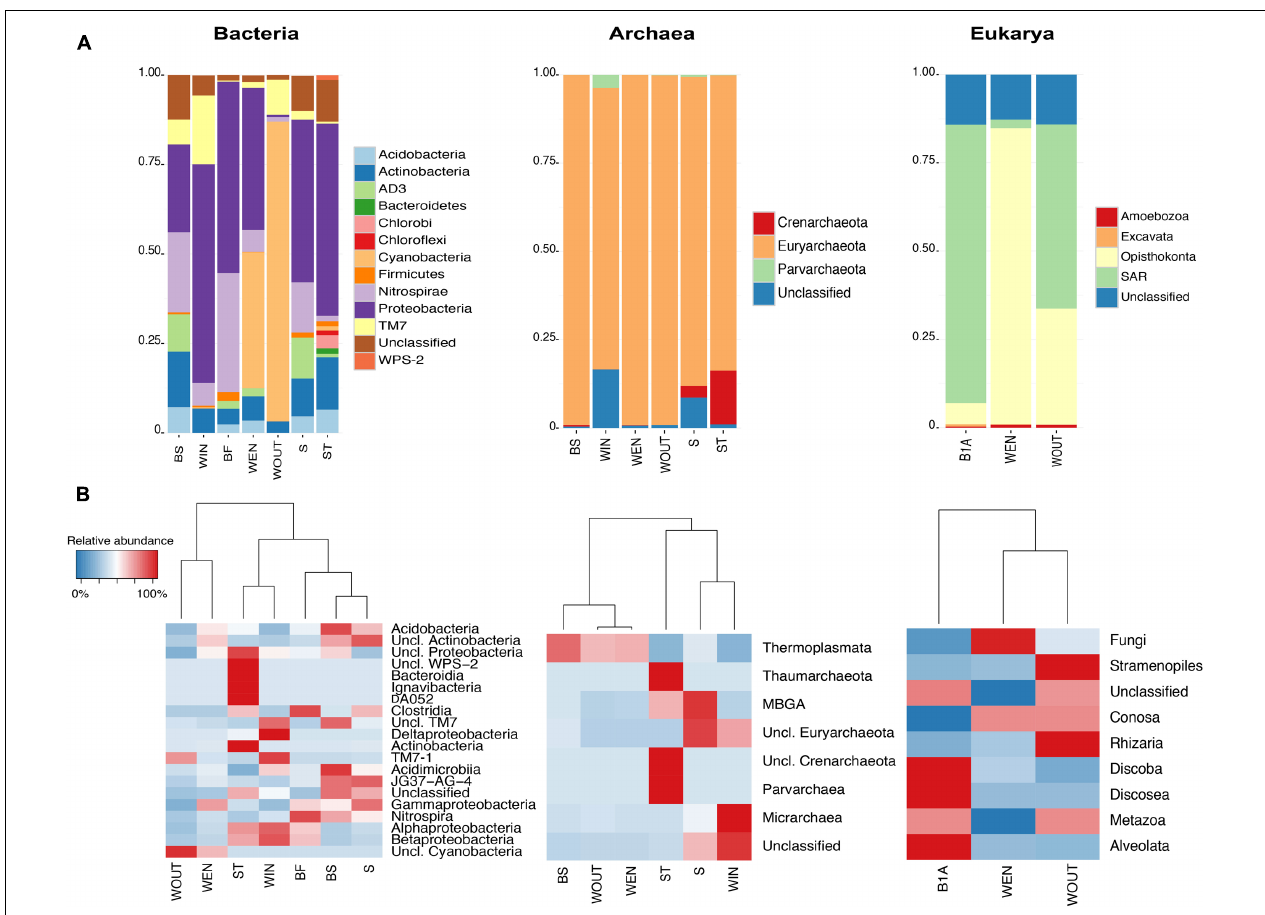
FIGURE 4 | Taxonomy profiles displaying the microbial diversity in the AMD samples, revealed by high throughput sequencing of the 16S/18S rRNA genes. (A) Bar plots displaying the relative abundances at the phylum level within Bacteria, Archaea, and Eukarya. (B) Heatmaps showing the main classes detected within each